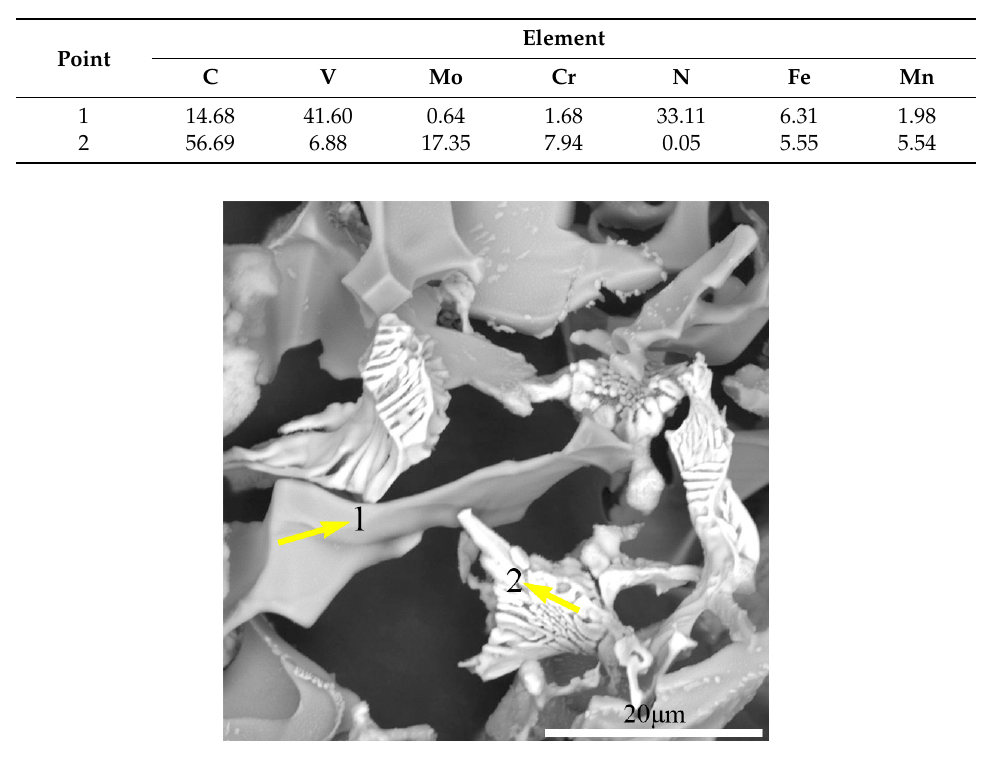
Figure 5. SEM micrographs showing the three-dimensional morphology of carbides or carbonitrides extracted from as-cast ESR ingot.